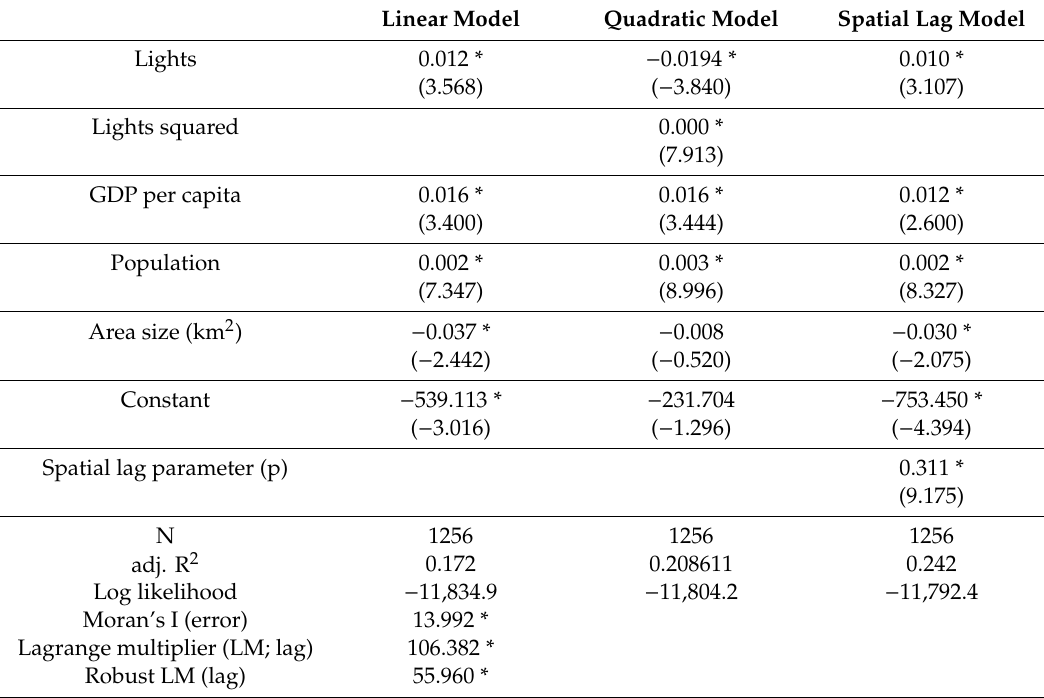
Table 6. Regression coe ffi cients and t and z statistics (in parentheses) of ordinary least squares (OLS) regressions and spatial lag